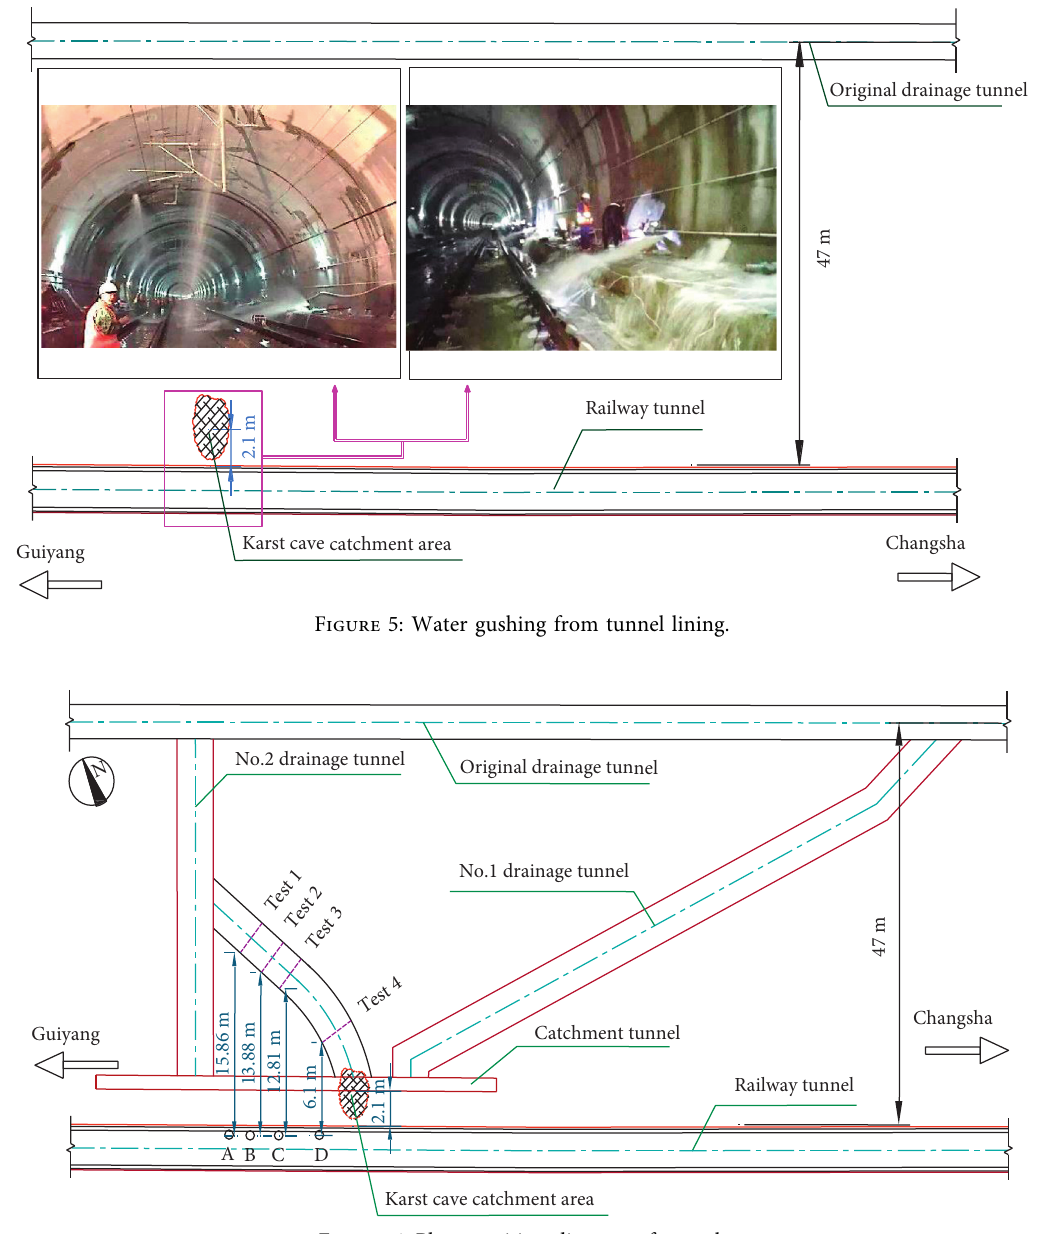
Figure 6: Plane position diagram of